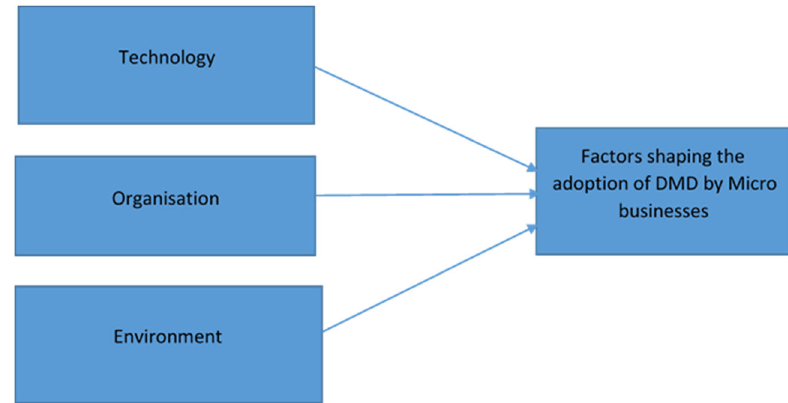
Fig. 1 Proposed study